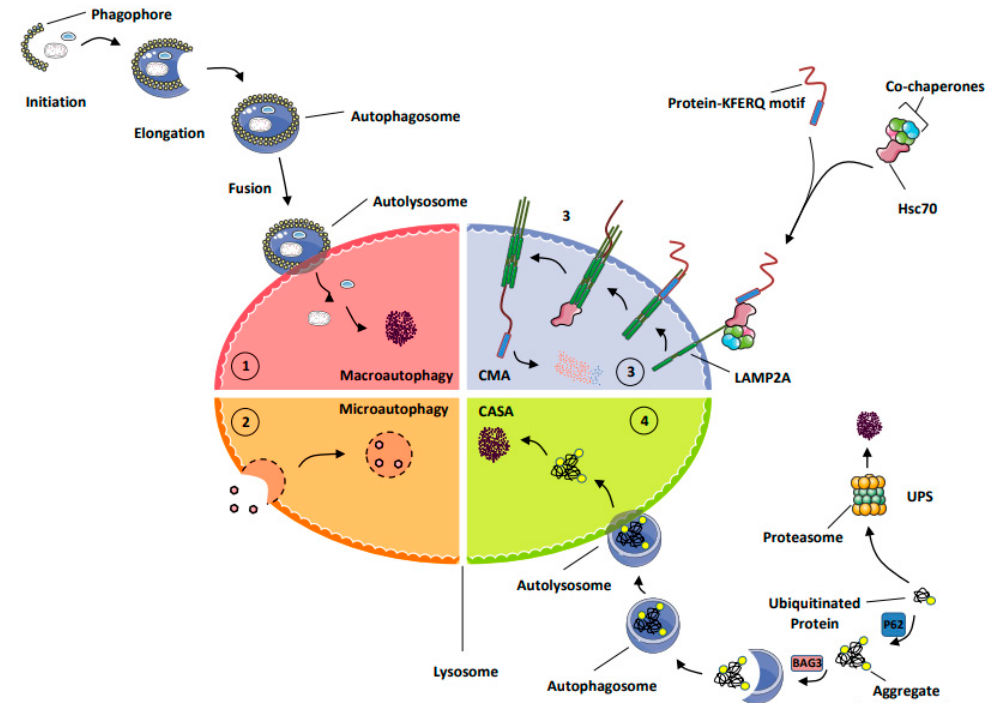
Figure 1. Schematic representation of the main processes of protein degradation. ( 1 ) MA (macro-autophagy) triggers the degradation of proteins, protein aggregates, lipids, and carbohydrates but also damaged organelles, as well as intracellular micro-organisms into the lysosomes. ( 2 ) Micro-autophagy corresponds to a less-selective form of autophagy that is carried out through the invagination of the lysosomal membrane around the material to be degraded. ( 3 ) Chaperone-mediated autophagy (CMA) allows the degradation of cytosolic proteins endowed with a KFERQ-like motif. During CMA, this motif is recognized by Hsc70, also called HSPA8, which triggers their unfolding and subsequent transport into the lysosome, where they are ultimately processed by lysosomal proteases. ( 4 ) Chaperone-assisted selective autophagy (CASA) ensures the selective ubiquitin-dependent degradation of dysfunctional chaperone-bound proteins in lysosomes. The ubiquitin proteasome system (UPS) is the cellular process by which short-lived proteins and dysfunctional or unfolded proteins are addressed to the proteasome for degradation.